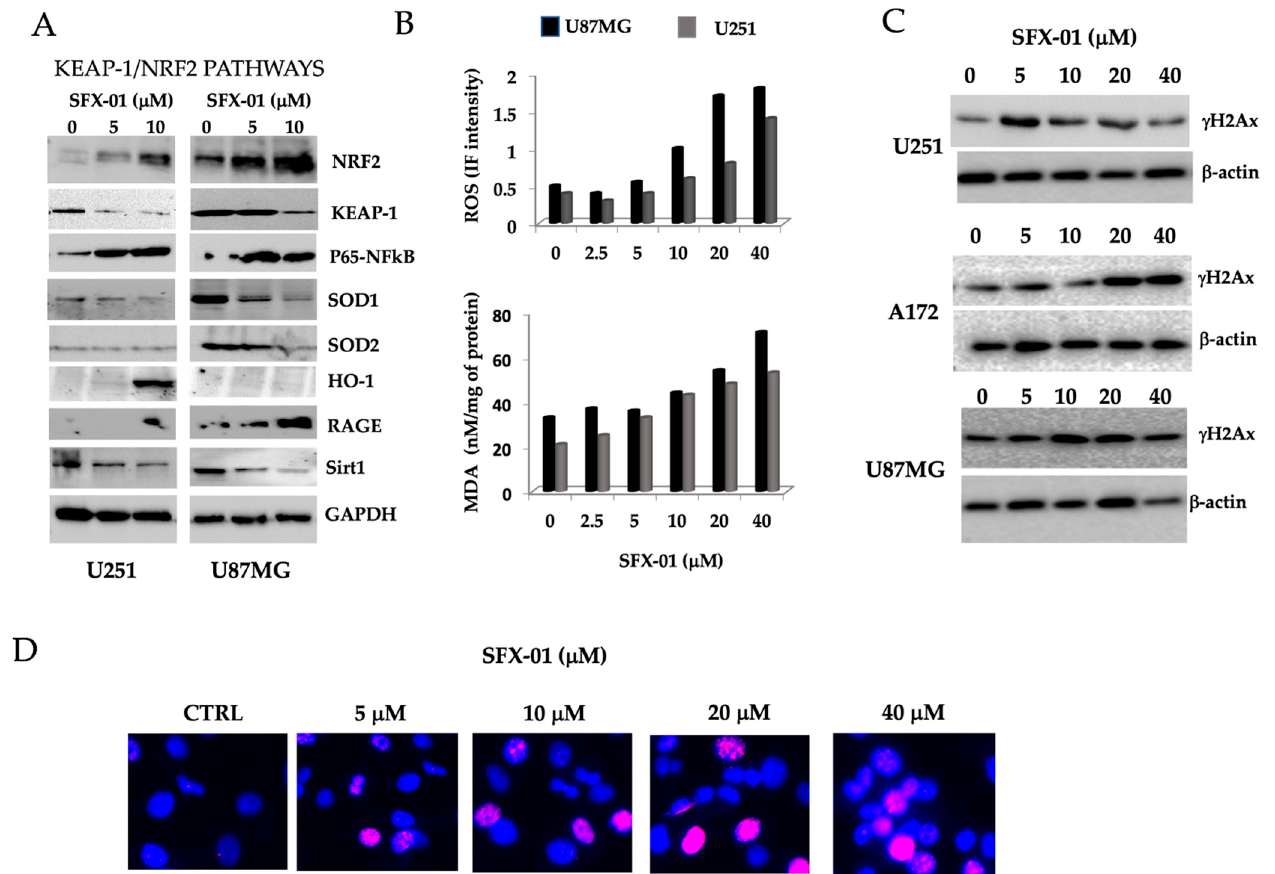
Figure 5. Sulforaphane induces reactive oxygen species (ROS) and amplified the RT-mediated oxidative nature of the microenvironment: ( A ) NRF2/Keap1 pathway activity in SFX-01-treated U251 and U87MG cultures growing with different doses of SFX-01. By Western blotting, we analyzed the expression of NRF2, KEAP1, P65-NFkB, SOD1, SOD2, heme oxygenase-1 (HO-1), RAGE, and Sirt1. ( B ) ROS levels (measured according to 2 ′ ,7 ′ -dichlorofluorescin diacetate, DCFDA) and lipid peroxidation (measured according to malondialdehyde peroxidation, MDA). Differences were statistically significant with p < 0.005 since SD was <15% of mean value ( C ) Western blotting assays performed in U87MG, U251, and A172 cell extracts for γ -H2Ax expression after treatments with increasing doses of SFX-01. ( D ) Immunofluorescence analysis of γ -H2Ax foci in U87MG cells treated with 5, 10, 20, and 40 µM SFX-01. Fixed cells were analyzed for expression of positive nuclei and, when possible, for number of γ -H2Ax foci.